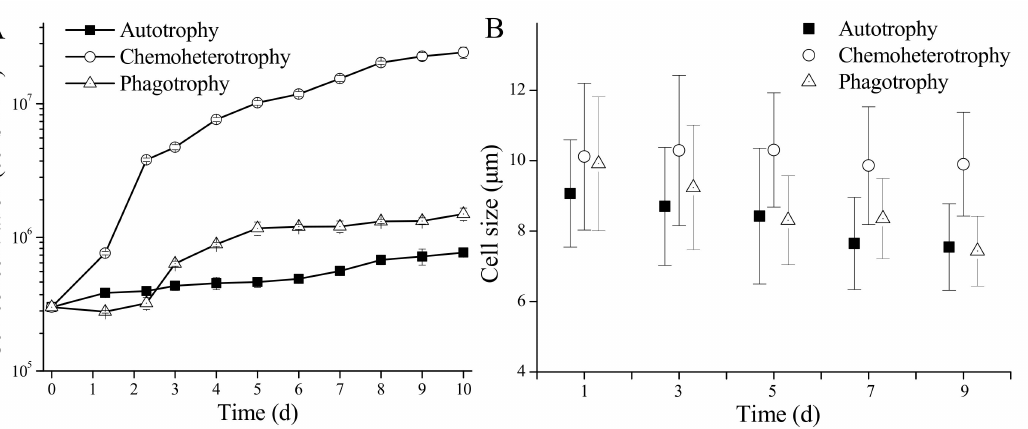
Figure 2. Growth ( A ) and cell size changes ( B ) of P. malhamensis with different nutritional modes. Error bars indicate the standard deviation. n =